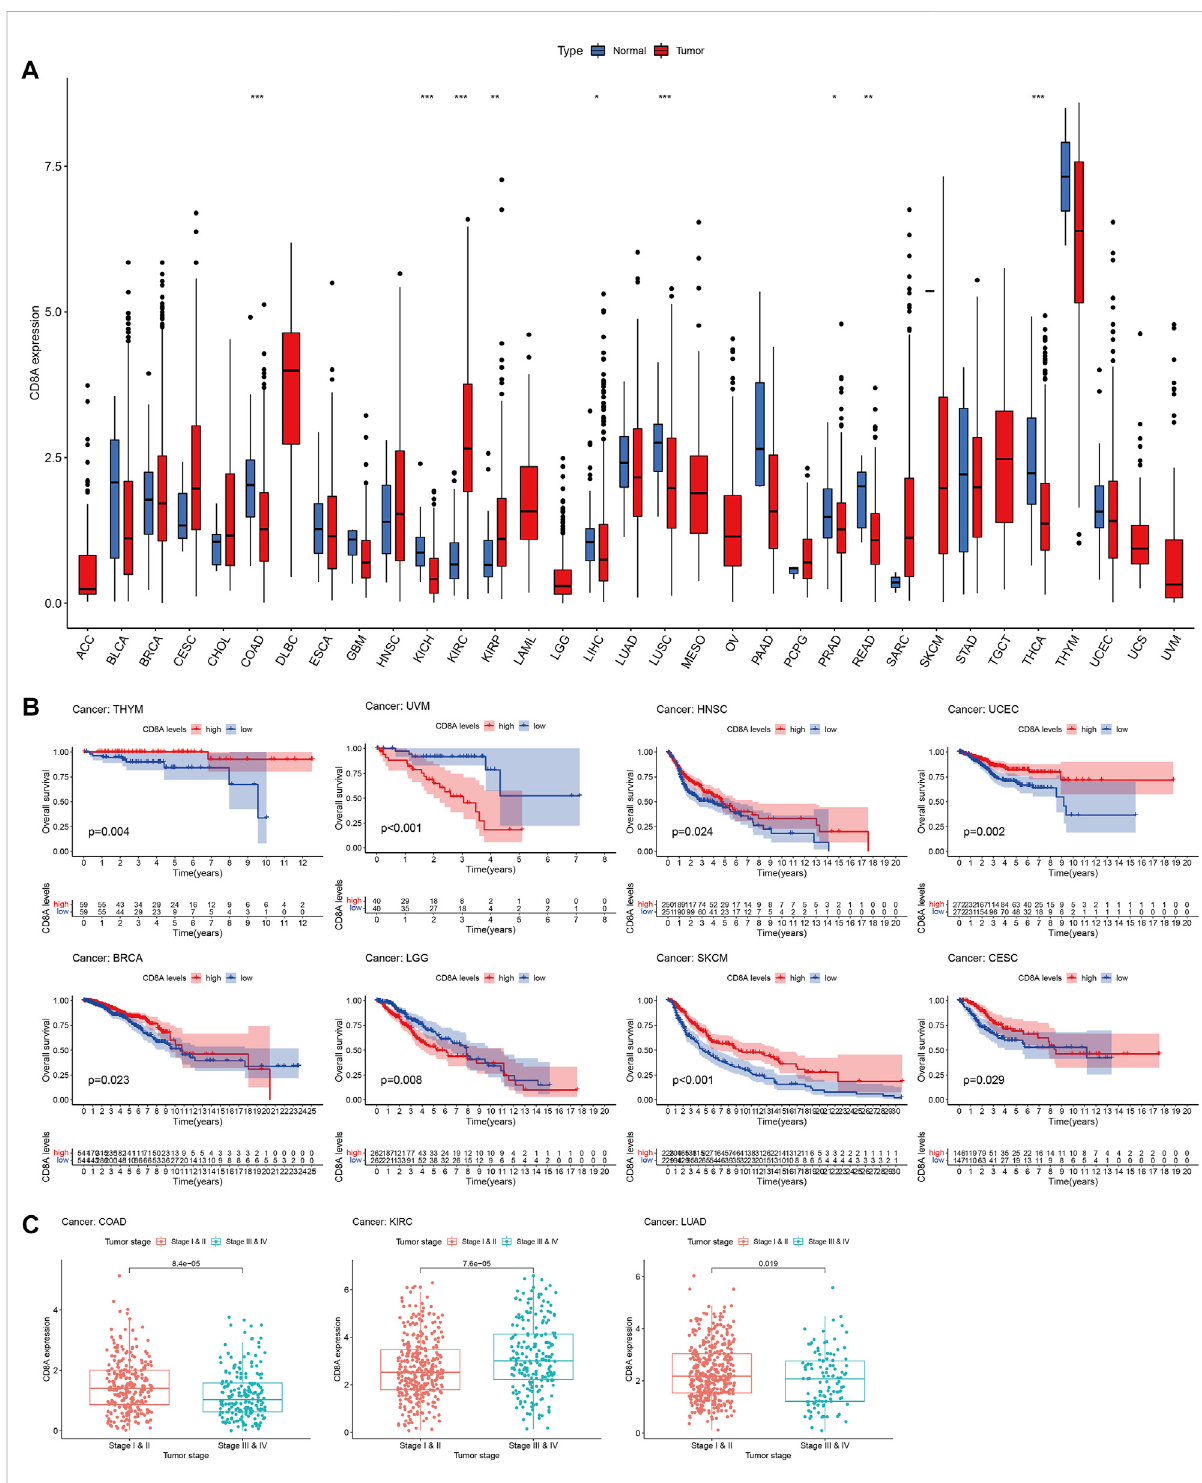
FIGURE 3 TranscriptomicpatternsandprognosisanalysisofCD8AinPan-Cancerdatasets (A) AnalysisofCD8Aexpressionpatternsattranscriptomiclevel based on TCGA ( p p < 0.05, pp p < 0.01, ppp p < 0.001) (B) Correlation between CD8A expression and overall survival as determined through Kaplan – Meier curve analysis in pan-cancer datasets of TCGA (C) Correlation between CD8A and tumor stages in colon adenocarcinoma (COAD), kidney renal clear cell carcinoma (KIRC), and lung adenocarcinoma